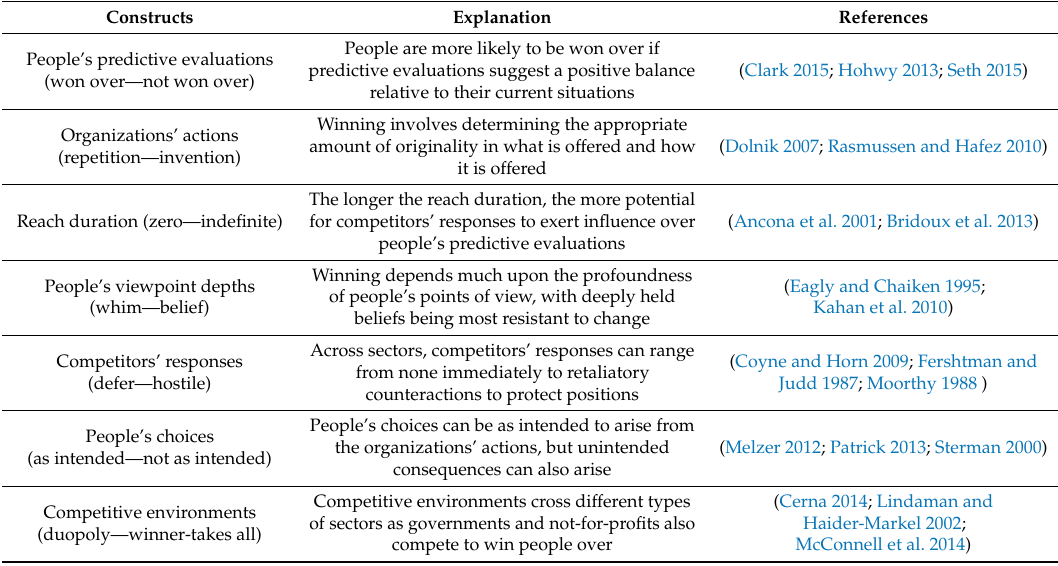
Table 1. Summary of